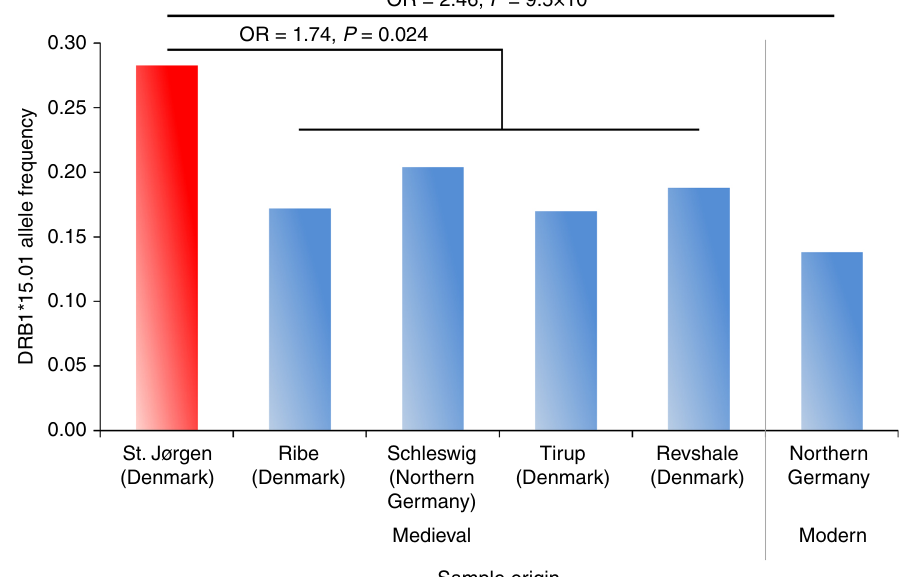
Fig. 2 Frequency of rs3135388-T variant. Allele frequency of rs3135388-T in 69 LL-positive medieval St. Jørgen individuals (red bar) and in four sample sets from medieval unaffected controls, compared with DRB1*15:01 data in a contemporary cohort of northern Germany from the DKMS bone marrow database (see Table 1 and Supplementary Information for sample sizes and other details). Odds ratio (OR) and P value from Fisher's exact test are reported.